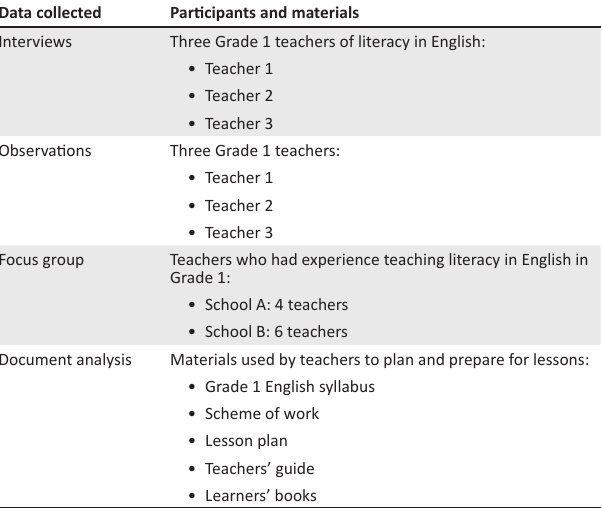
TABLE 1: Summary of data collection instruments and